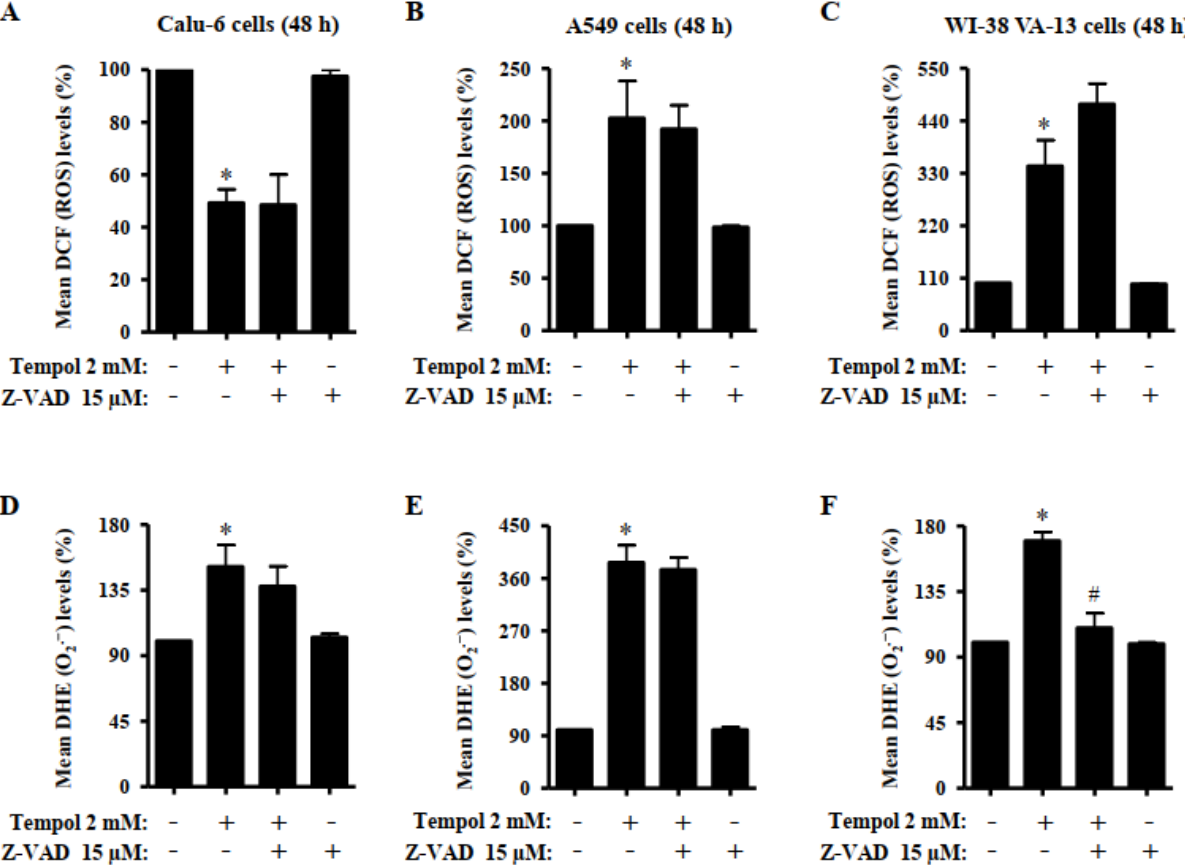
Figure 6. Effects of Tempol and/or Z-VAD on ROS levels in Calu-6, A549, and WI-38 VA-13 cells. Exponentially growing cells were pretreated with Z-VAD for 1 h and then treated with 2 mM Tempol for 48 h. Intracellular DCF (ROS) and DHE (O 2 •− ) levels in lung cells were measured using a FACStar flow cytometer. ( A – C ): The graphs indicate the mean DCF (ROS) levels (%) in Calu-6 ( A ), A549 cells ( B ), and WI-38 VA-13 cells ( C ). ( D – F ): The graphs indicate the mean DHE (O 2 •− ) levels (%) in Calu-6 ( D ), A549 cells ( E ), and WI-38 VA-13 cells ( F ). ANOVA test was used. * p < 0.05 compared to Tempol-untreated control cells. # p < 0.05 compared to cells treated with Tempol only. Changes in GSH levels were assessed in lung cells using a CMF fluorescent